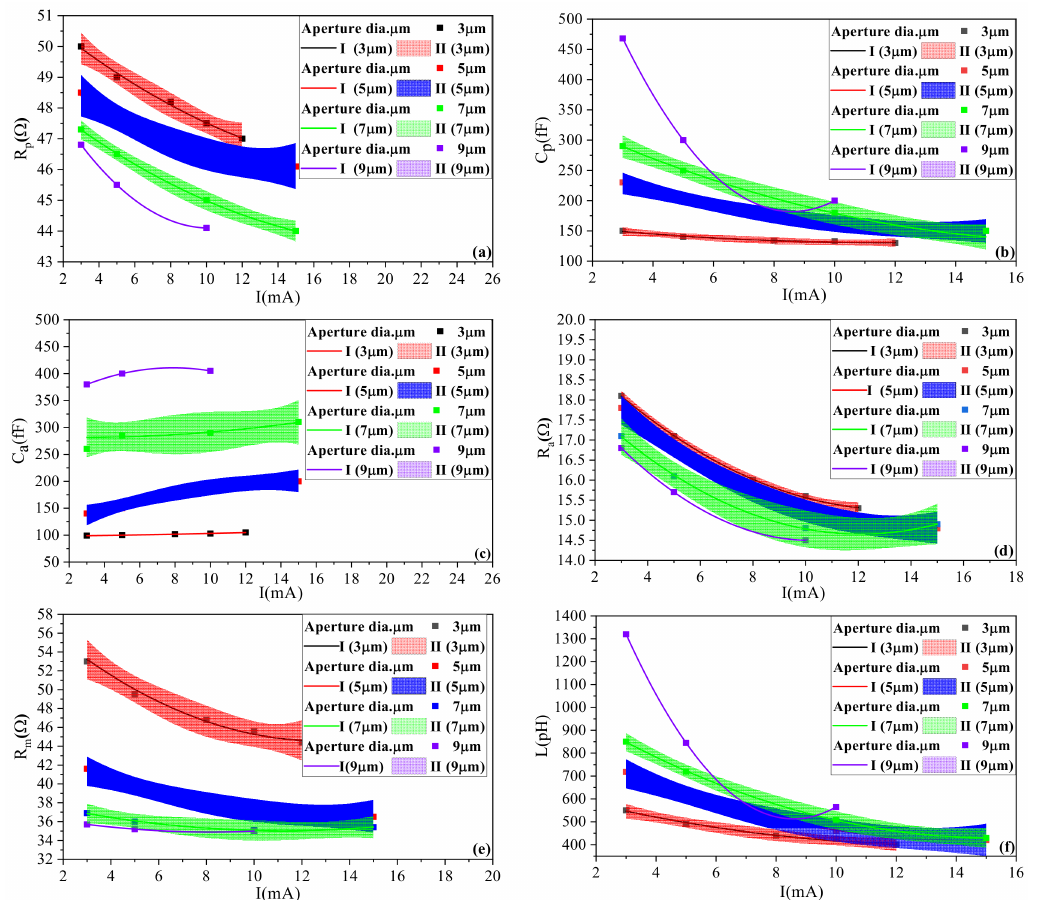
Figure 6. ( a – f ) show the extracted values and 95% fit confidence bounds of R p , C p , C a , R a , R m , and L , respectively, as a function of different bias currents for the 3, 5, 7, and 9 µ m 850 nm oxide aperture diameter VCSELs at 25 ◦ C. In the legend, I is the polynomial fitting curve, II is the 95% fit confidence